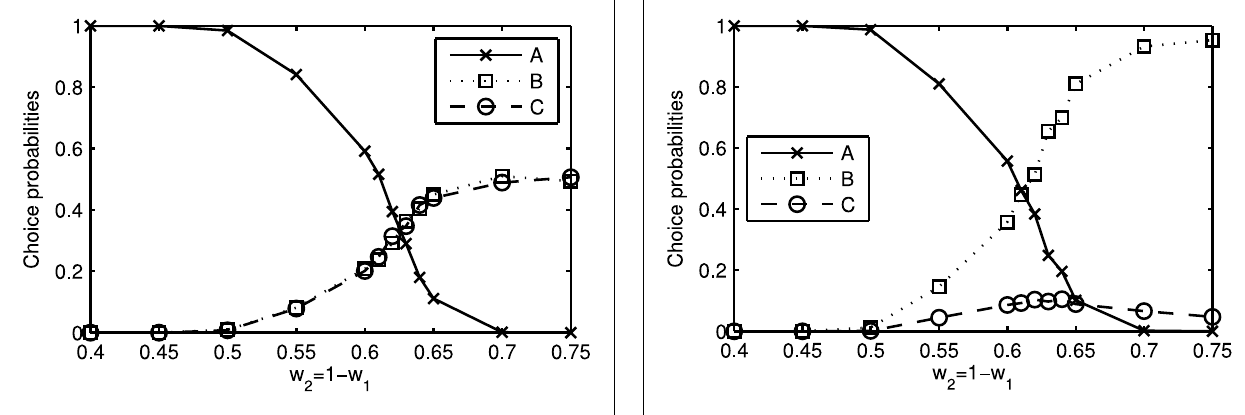
FIGURE 6 | Choice probabilities for choice between three alternatives A = (9, 1), B = (1, 9), and C = (1, 8.5) and different attention weights w 1 and w 2 for the two attributes. The abscissa is labeled with increasing values of w 2 corresponding to decreasing values of w 1 . For 0.61 ≤ w 2 <0.65 an attraction effect can be observed.